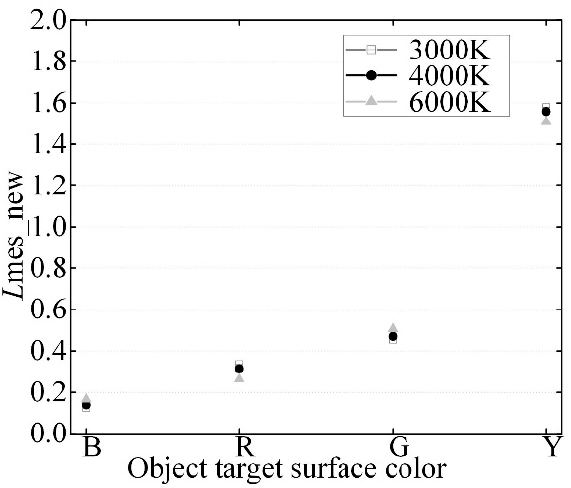
Figure 7. L mes_new value of four-colored targets under three lighting conditions. It can be observed that the L mes_new of the yellow surface target is the largest, followed by the green surface target. Conversely, the luminance of the blue surface target is the smallest. Furthermore, the L mes_new value of the yellow and red surface targets increases with a decrease in LED CCTs, but the L mes_new value of the blue and green surface targets increases with the increase of LED